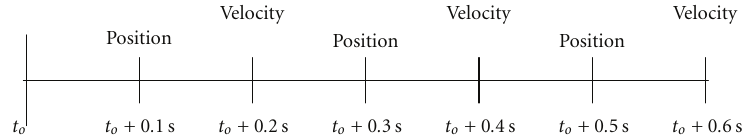
Figure 2: Sensor reports from di ff erent sensors are interleaved to provide uniform